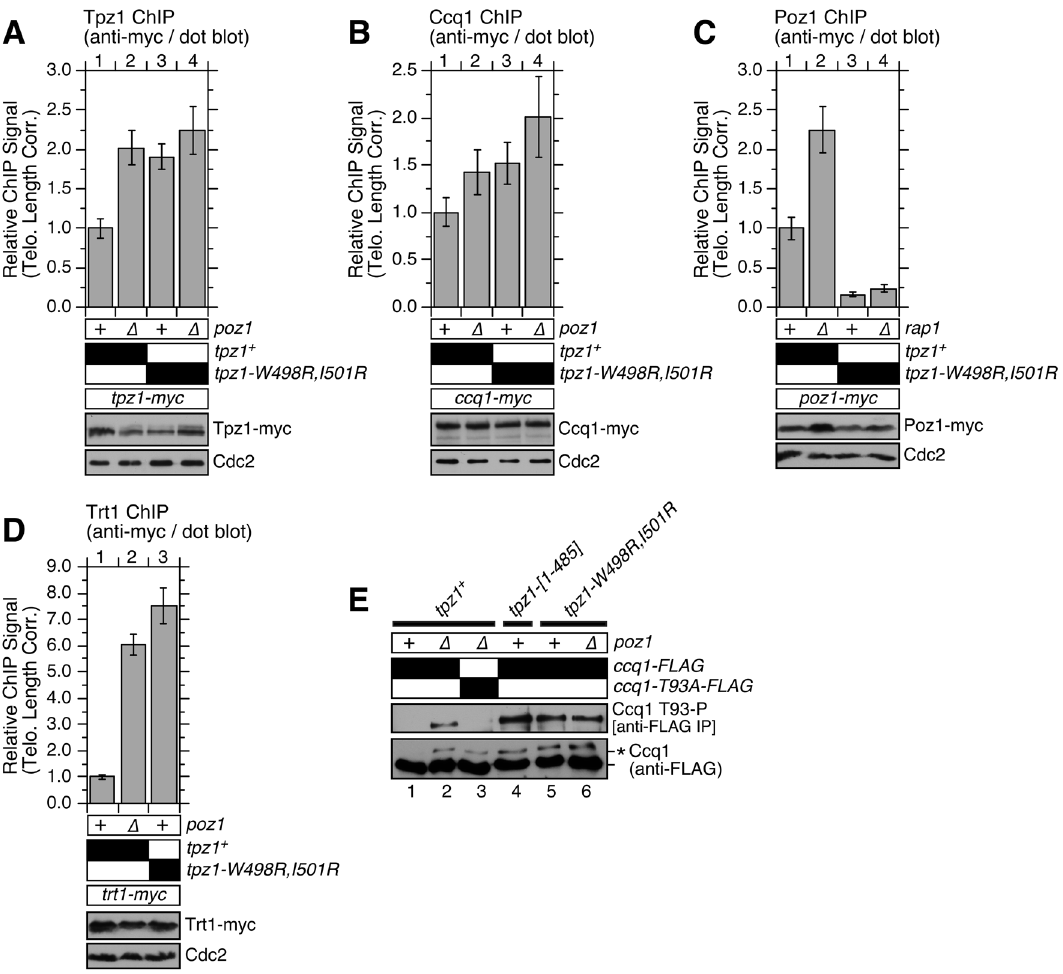
Figure 7. Telomere association of Tpz1, Ccq1, Poz1 and Trt1 TERT in Tpz1-Poz1 interaction mutant cells. Effects of disrupting Tpz1-Poz1 interaction on telomere association for ( A ) Tpz1, ( B ) Ccq1, ( C ) Poz1 and ( D ) Trt1 TERT were monitored by dot-blot ChIP assays and corrected for changes in telomere length [36]. Error bars represent standard error of the mean from three to eight independent experiments. Statistical analysis of ChIP data by 2-tailed Student’s t-test is shown in Table S5. Southern blot analysis of telomere length for strains used in ChIP assays is shown in Figure S12, and raw data for ChIP assays are shown in Figure S13. Expression levels of myc-tagged proteins were monitored by anti-myc western blot analysis of whole cell extracts. Anti-Cdc2 blots served as loading control. ( E ) Ccq1 Thr93 phosphorylation, detected by anti-phospho(S/T)Q (Phospho- (Ser/Thr) ATM/ATR substrate antibody, is enhanced in mutant cells lacking Tpz1-Poz1 interaction. For anti-FLAG blots, asterisk (*) indicates hyper- phosphorylated form of